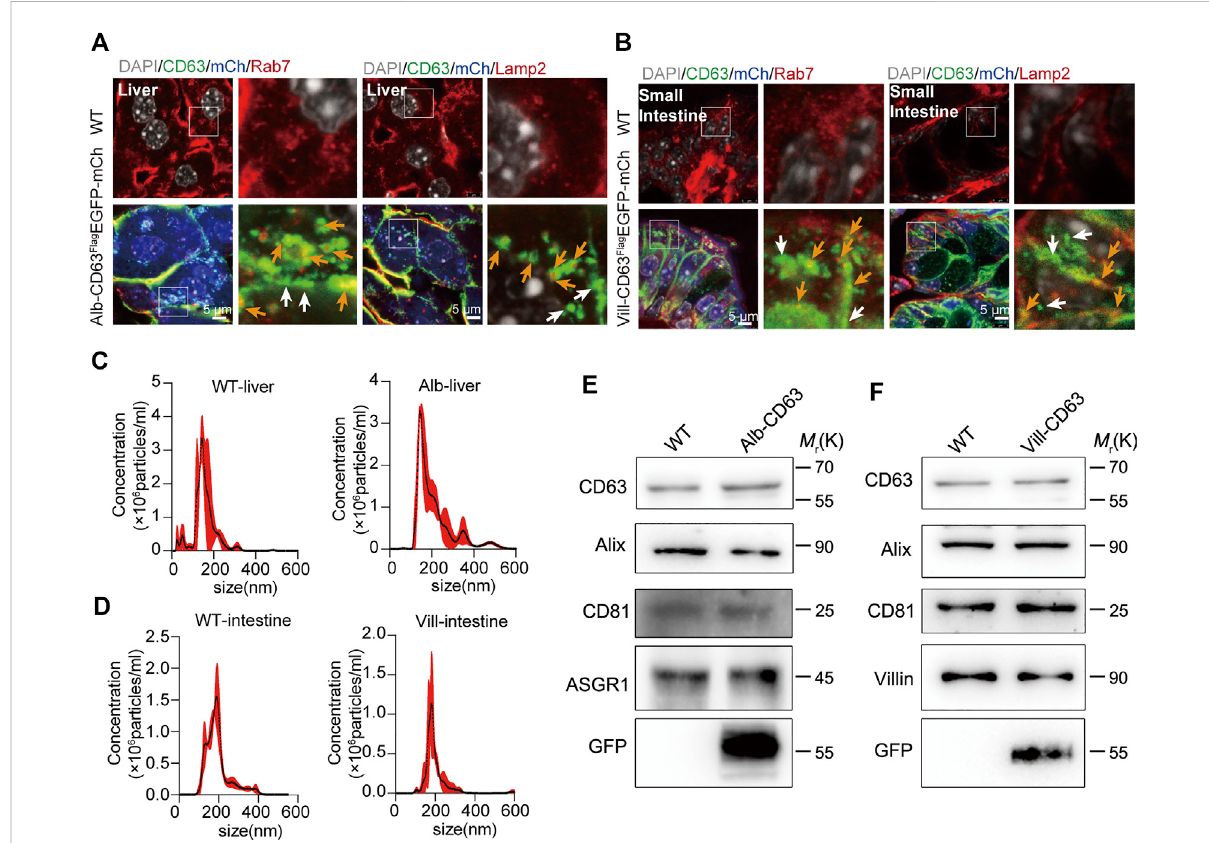
FIGURE 3 The organelles and characterization of tissue-derived EGFP EVs on tissue speci fi c CD63FlagEGFP-mCherry mouse. (A,B) Immunostained organellesofMVB(Rab7)andlysosome(Lamp2)colocalizationwithEGFPandmCherry fl uorescentintheliverofalb-CD63 Flag EGFP-mCherrymouse (A) and in the intestine of Villin-CD63 Flag EGFP-mCherry mouse (B) . Grey, Nucleus; Green, GFP; Blue, mCherry; Red, Rab7/Lamp2 (Scale bar, 5 um). (C,D) Nanoparticle tracking analysis (NTA) of EVs isolated from primary cell cultures. (WT-liver, wild-type-liver; Alb-liver, Alb-CD63 Flag EGFP- mCherry-liver; WT-intestine, wild-type-intestine; vill-in, villin-CD63 Flag EGFP-mCherry-intestine). ( n = 4) (E,F) Western blot analysis of the protein markersofexosomes(CD63,Alix,CD9),tissuespeci fi csEV(ASGR1,hepatic-EVspeci fi cprotein;Villin,intestine-EVspeci fi cprotein)andtissuespeci fi c CD63 Flag EGFP-mCherry mouse positive sEV (GFP). Data indicate the mean ±